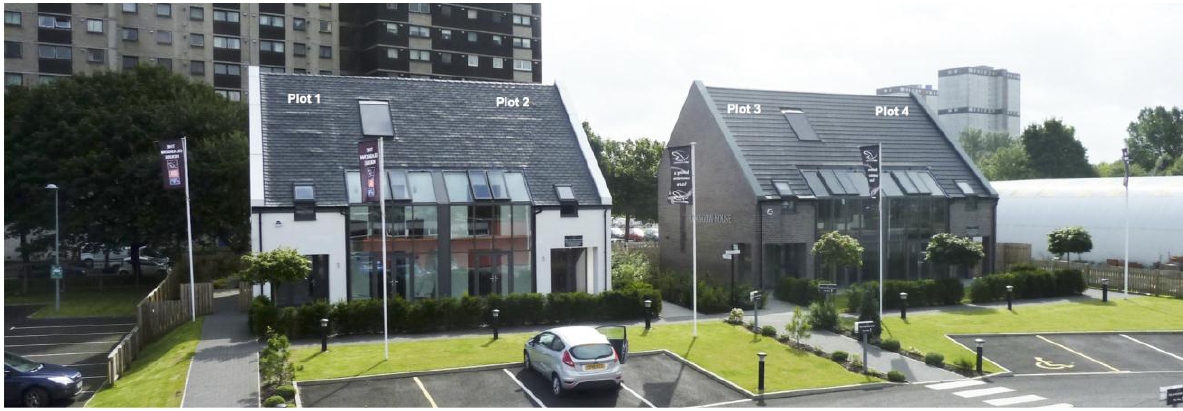
Figure 1. The Glasgow House: Plots 1 and 2 ( left ); Plots 3 and 4 ( right